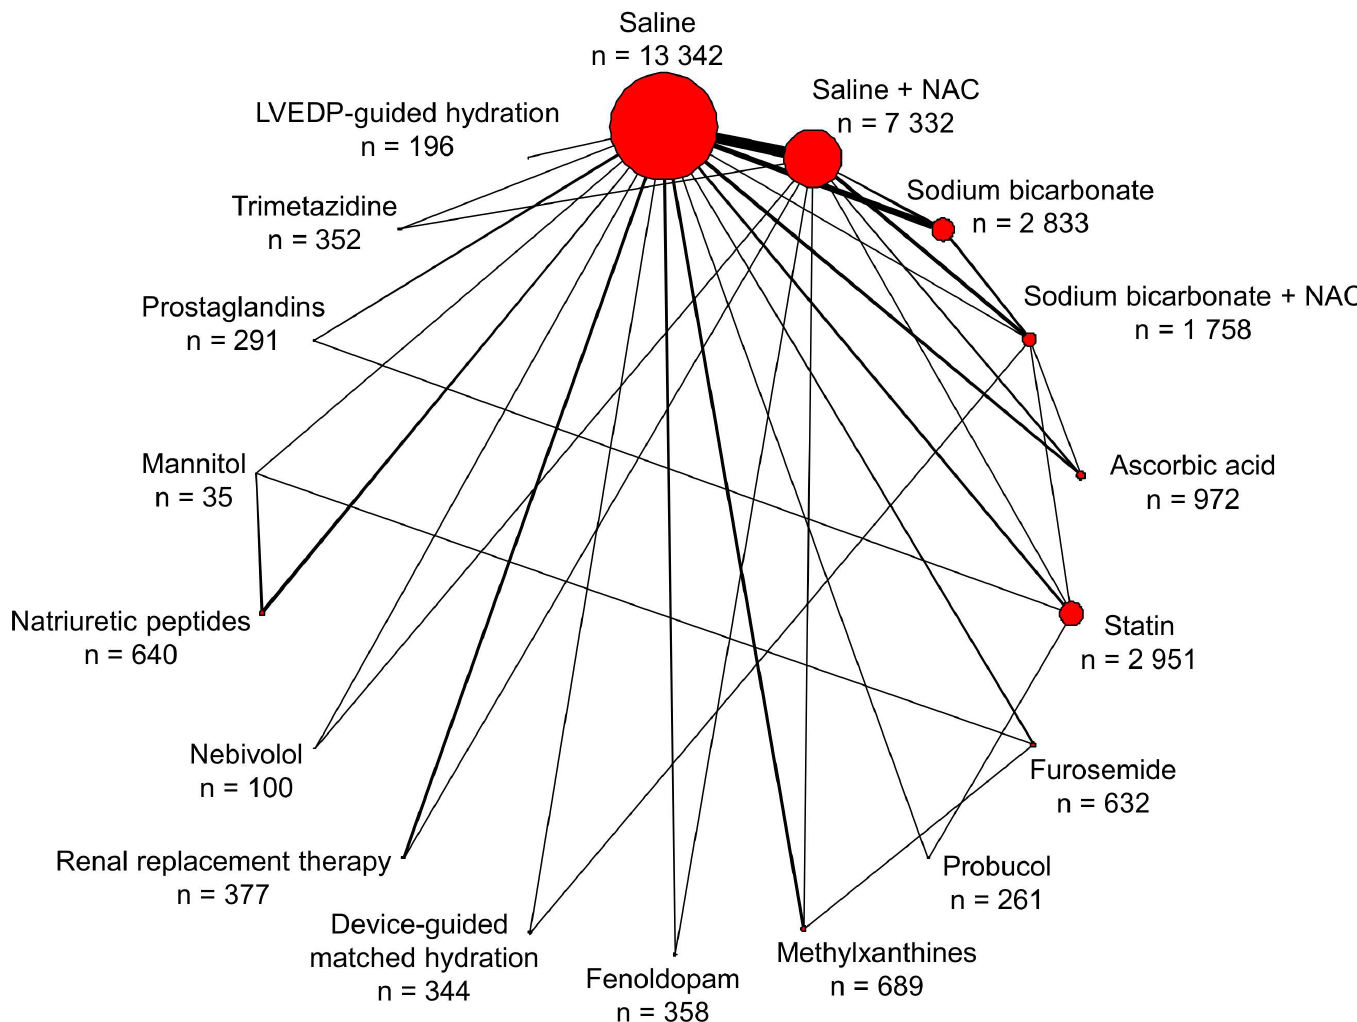
Fig 2. Network of treatment comparisons for prevention of contrast-induced acute kidney injury in patients undergoing cardiovascular invasive procedures. The size of the nodes corresponds to the numberof trials that studied the treatments. Directly comparedtreatments are linked with a line, the thickness of which correspondsto the numberof trials that assessedthe comparison. LVEDP = left ventricularend-diastolic pressure; NAC = N-acetyl cysteine; n = number of patients allocatedto a specific